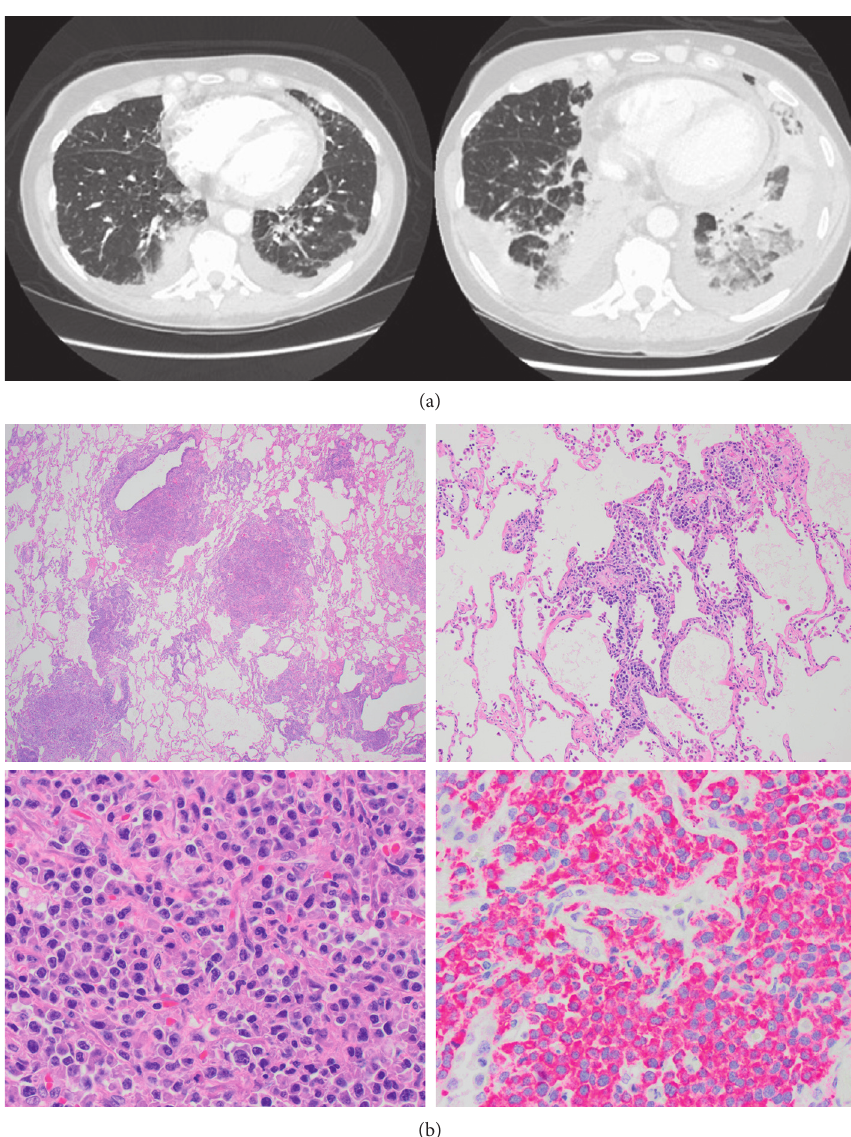
Figure 1: (a) Coronal sections of computed tomography showing worsening of bilateral lower lobe consolidation along with extensive ground-glass density, interlobular septal thickening. (b) Pathological specimen showing infiltration of lung parenchyma by kappa light chain restricted atypical plasma cells with a large, round to irregular nuclei, variably prominent nucleoli, and moderate amounts of eosinophilic cytoplasm. Flow cytometry showed 17.9% plasma cells with the following immunophenotypic markers (CD5 ( − ), CD10 ( − ), CD19 ( − ), CD20 ( − ), CD38 (bright+), CD45 (dim+), CD56 (partial dim+), CD138 (variably+), and CD319 (+)) (Hematoxylin and eosin; 20 x , 100 x , 500 x , and 500 x ,